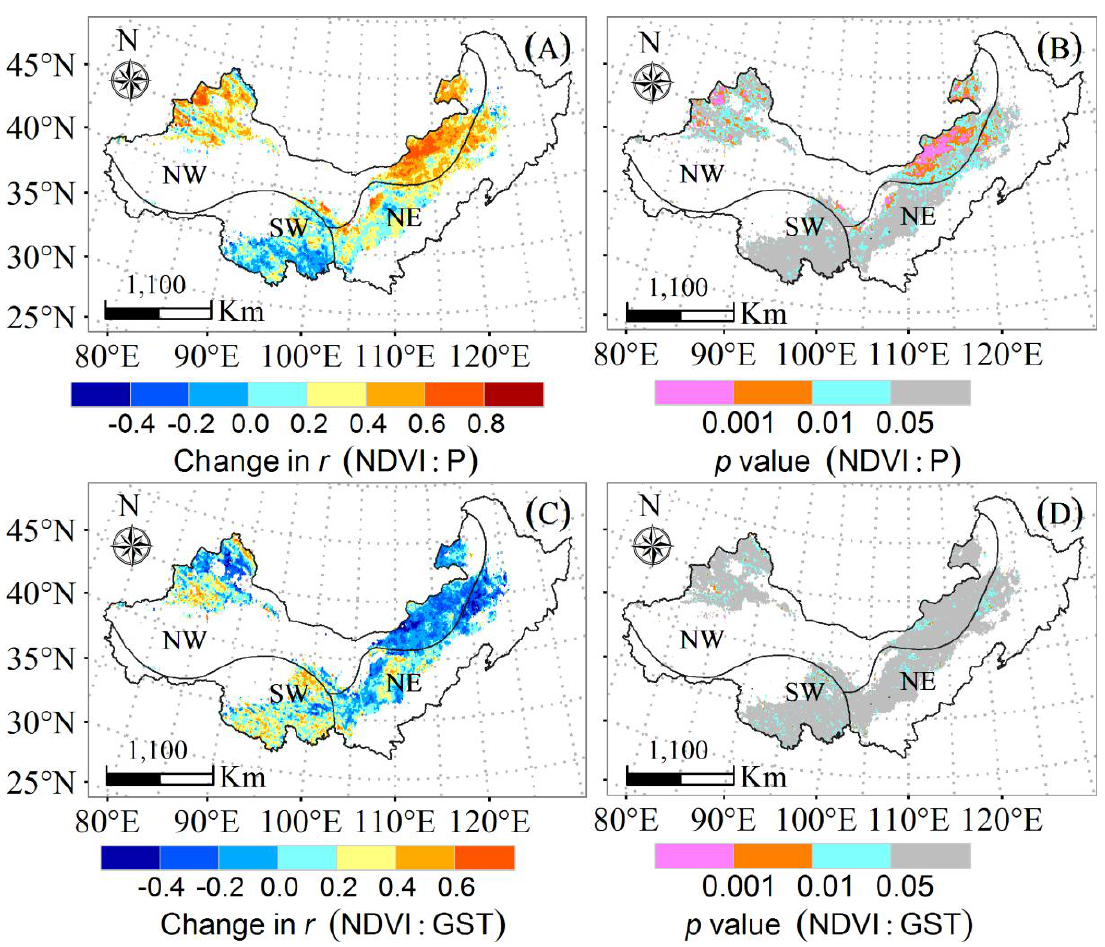
Figure 4. The distribution of spatial correlation coefficients ( r ) ( A ) and the corresponding p values ( B ) between mean growing season grass NDVI and annual precipitation (P), and the distribution of spatial r ( C ) and corresponding statistical p values ( D ) between mean growing season grass NDVI and mean growing season temperature